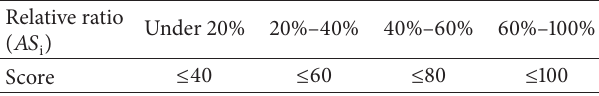
Table 4: Scoring method according to accident severity index ( 𝐴𝑆 𝑖 ).